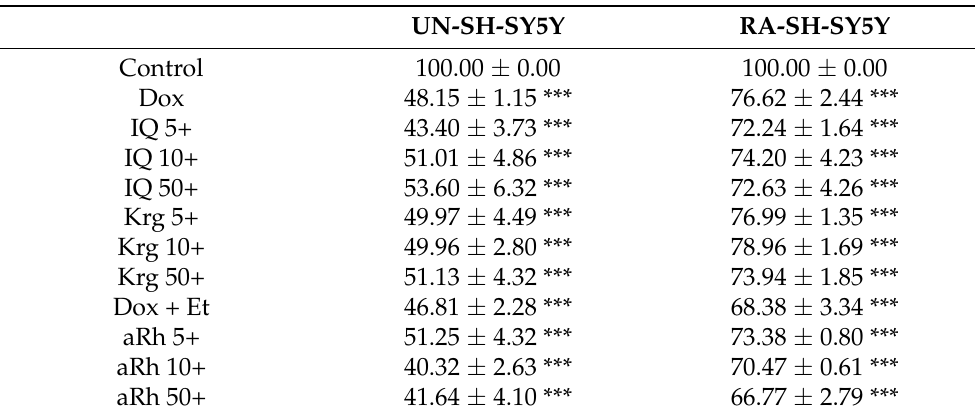
The cells were pre-treated for 30 min with vehicle (Et, 0.7% ethanol), isoquercitin (IQ, 5–50 µ M), kaempferitin (Krg, 5–50 µ M) or α -rhamnoisorobin (aRh, 5–50 µ M) followed by 24 h exposure to doxorubicin (Dox, 0.375 and 0.5 µ M for UN- and RA-SH-SY5Y, respectively). Cell viability was measured by WST-1 assay. The data were normalized to the vehicle-treated cells and are presented as the mean ± SEM. The data were analyzed by one-way ANOVA. *** p <0.001 vs. vehicle-treated